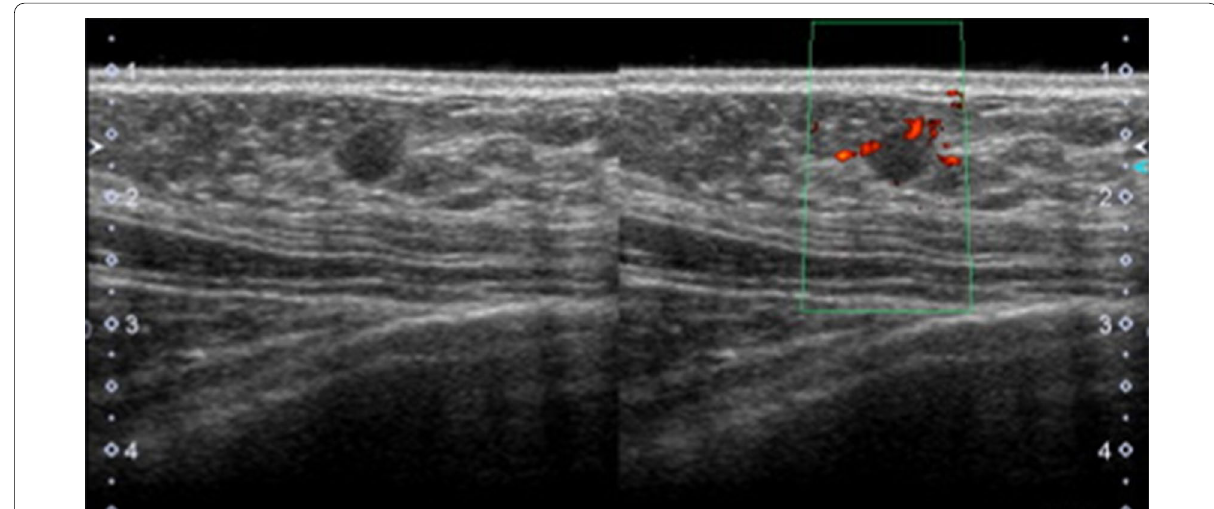
Fig. 1 Ultrasound findings of case 1. Ultrasound showed a 7 mm-sized well-defined oval mass with a disrupted anterior border. Color Doppler revealed intra-tumoral abundant blood flow